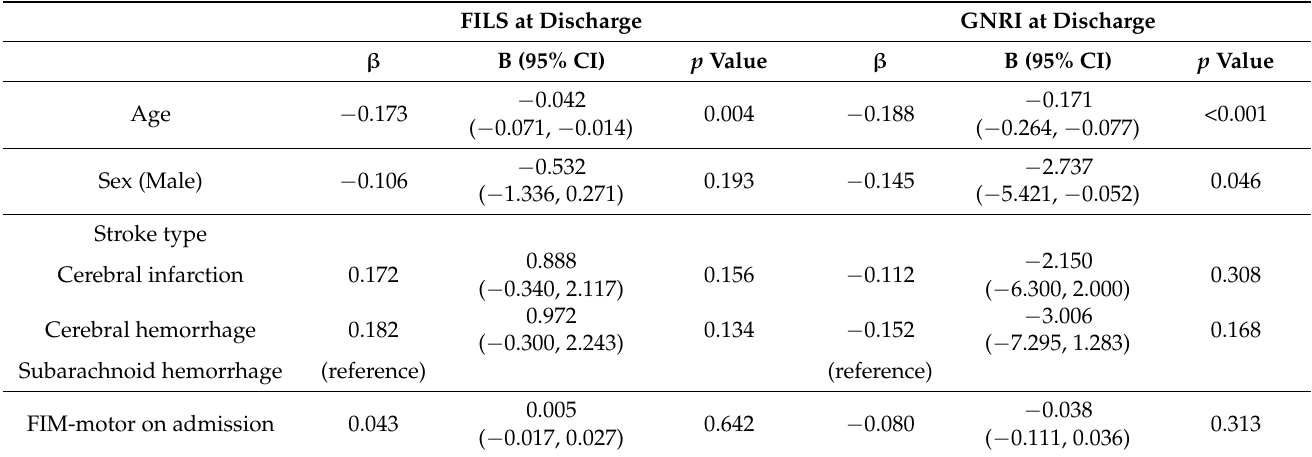
Table 4. Multivariate linear regression analysis of study outcomes (FILS and GNRI) at discharge in post-stroke hospitalized patients with